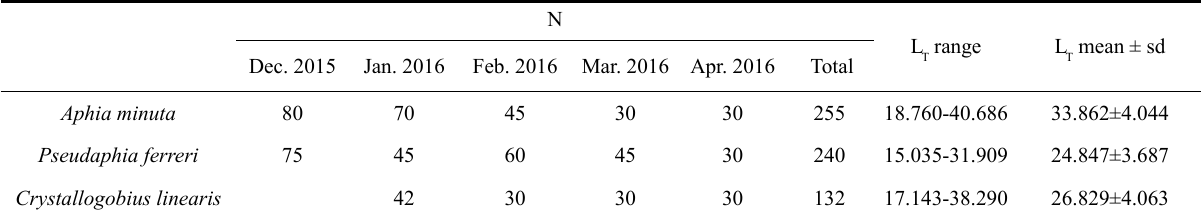
Table 1. – Number of specimens sampled during the fishing season 2015-2016 and the total length range (L mean (L mean) in mm and the standard error (sd) in mm, by species and T